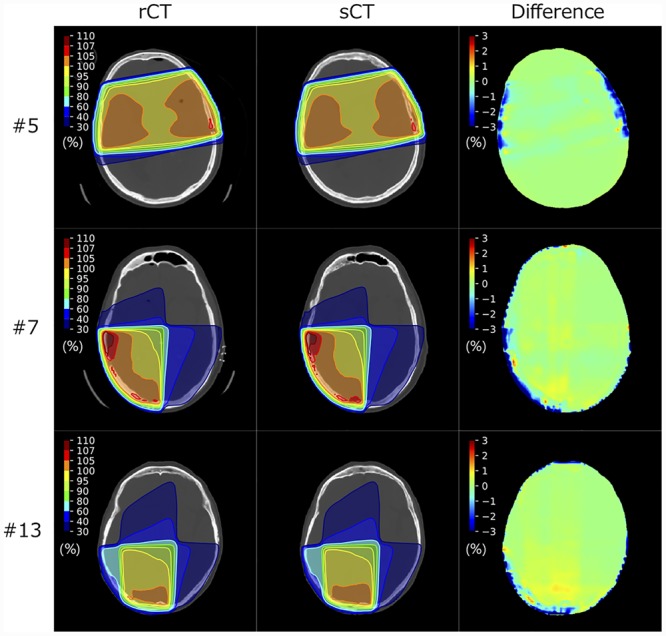
Dose distributions of sCTmulti of representative 3D-CRT plans and associated difference maps showing the dose difference relative to the prescribed dose of 20 Gy.